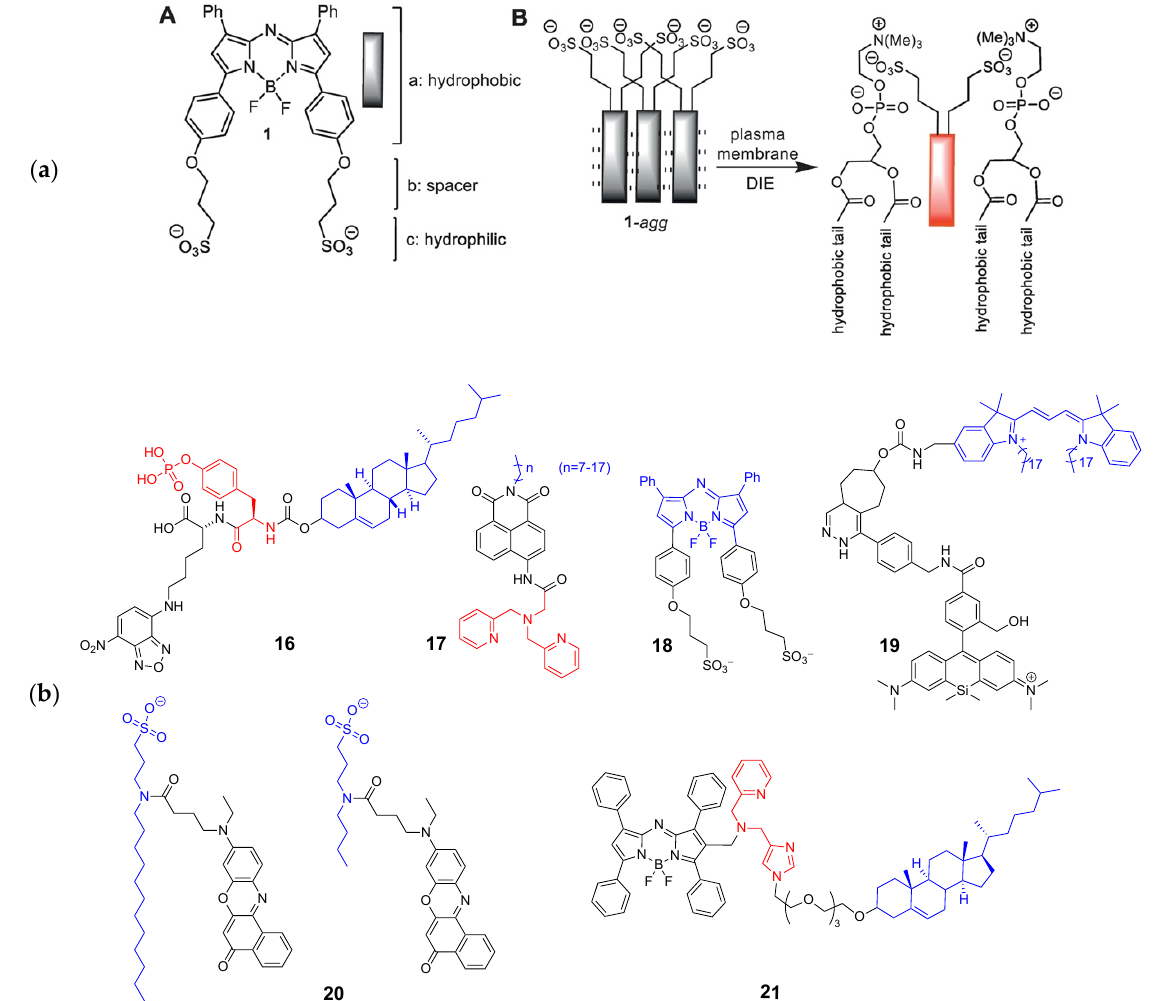
Figure 4. ( a ) A: Amphiphilic NIR-AZA probe ( 18 ); B: Simplified schematic showing representation of membrane DIE activation of aggregated 18 . Reprinted with permission from ref. [41], copyright Elsevier 2018; ( b ) Structures of membrane-targeted probes (blue: targeting moiety; red: responsive moiety).